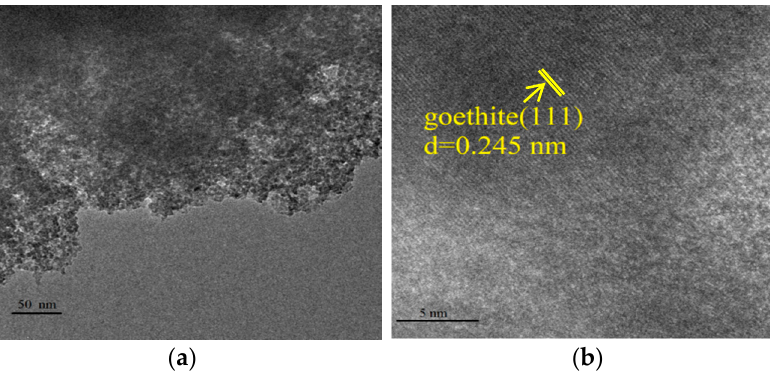
Figure 4. TEM analysis of Fhy ( a ) before and ( b ) after the photodissolution with 1.0 mM oxalic acid.